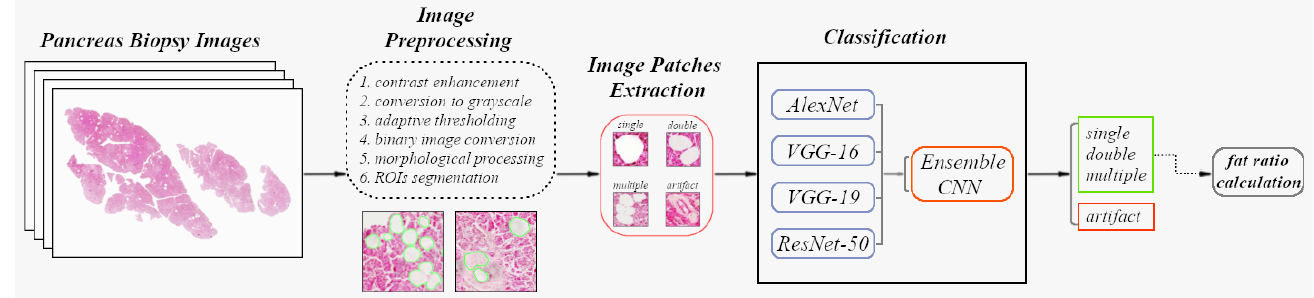
Figure 1. Flowchart of the proposed methodology for the evaluation of pancreatic fat infiltration in microscopic biopsy images. An image preprocessing step first aims to the segmentation of circular- white structures of interest relating to lipid droplets. Then, these are extracted as image patches and classified using a trained multi-CNN system. Therefore, the elimination through the classification of false-positive fat findings as histological artifacts leads to more accurate quantification of the steatosis prevalence ratio in the